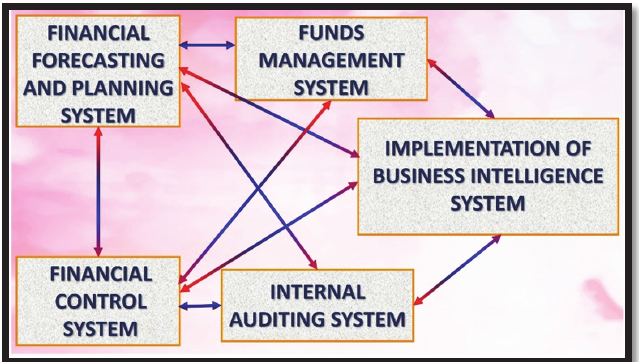
Fig. 4. The Proposed Organizational Excellence MIT90’s, McKinsey 7S’s and UTAUT- Malaysian